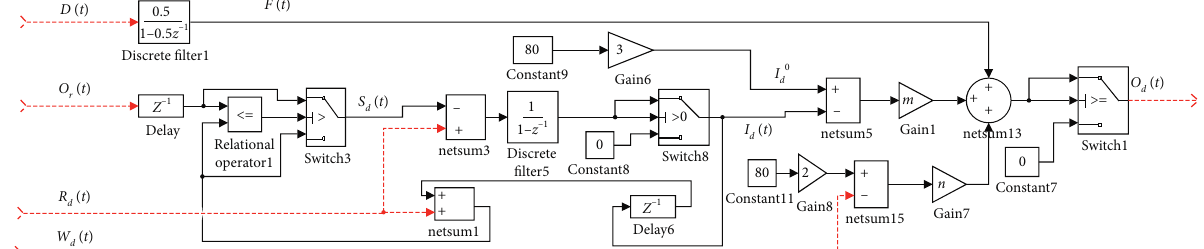
Figure 3: The block diagram of the distribution center from the local decision perspective.